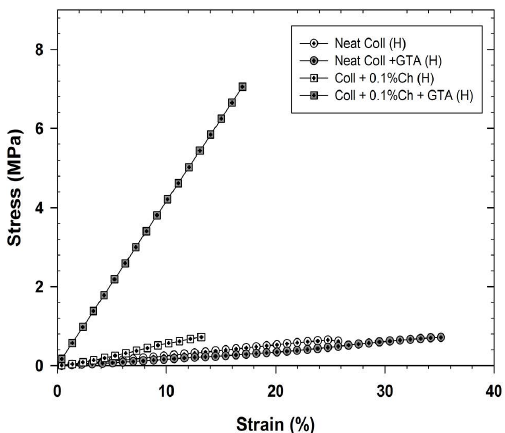
Figure 4. Stress-strain characterization of chitosan-coated and non-coated collagen membranes crosslinked with glutaraldehyde (GTA) vapor. Analyses were performed on dried membranes ( n = 4). Ch: Chitosan.